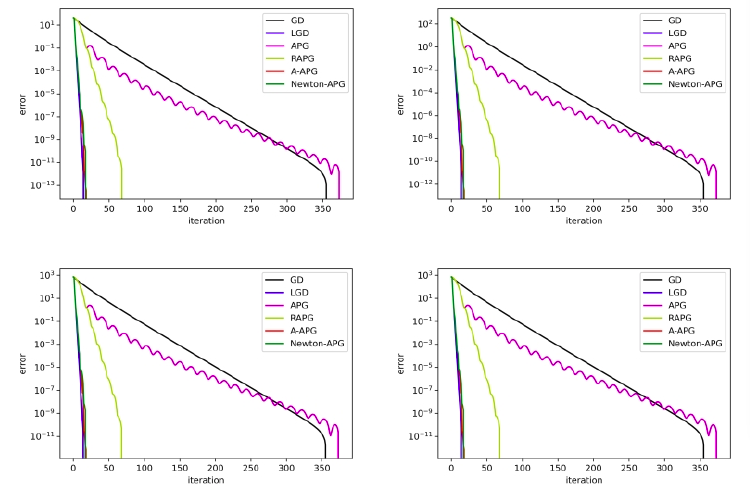
Figure 1. The error curves when n = 128, 1024, 2048, 4096 for Example 1.